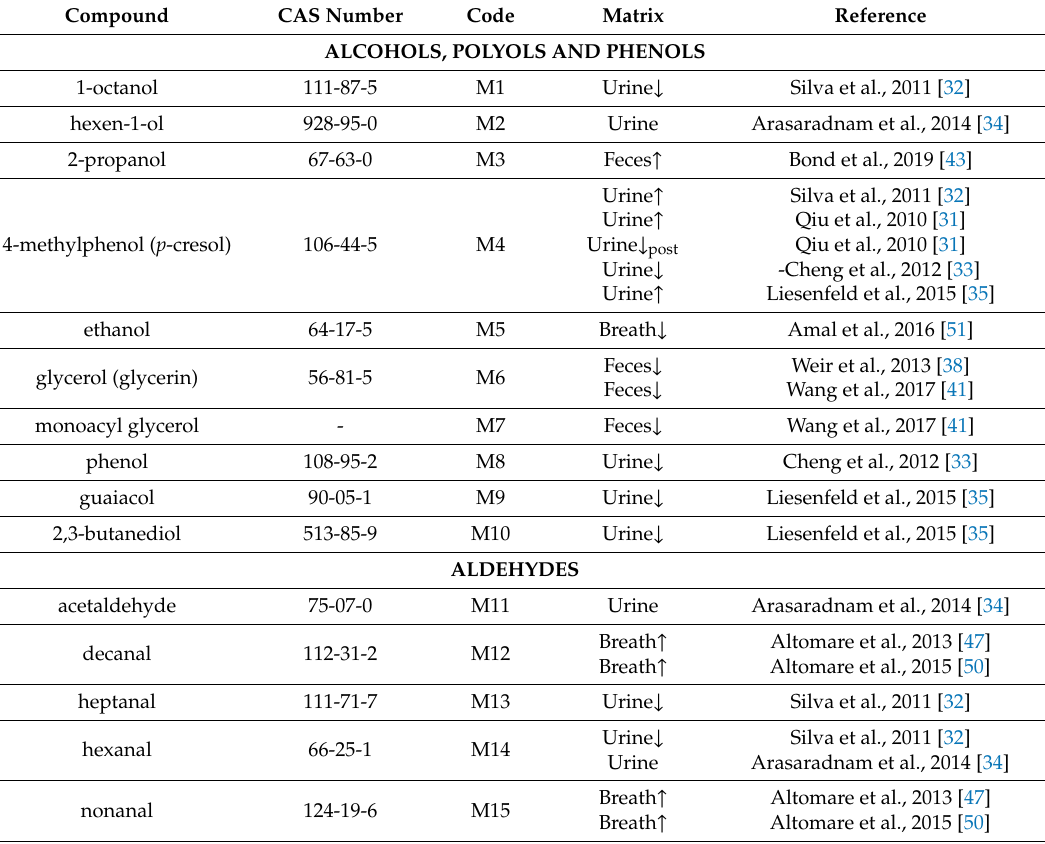
Table 2. List of the most relevant compounds reported as potential biomarkers of CRC.